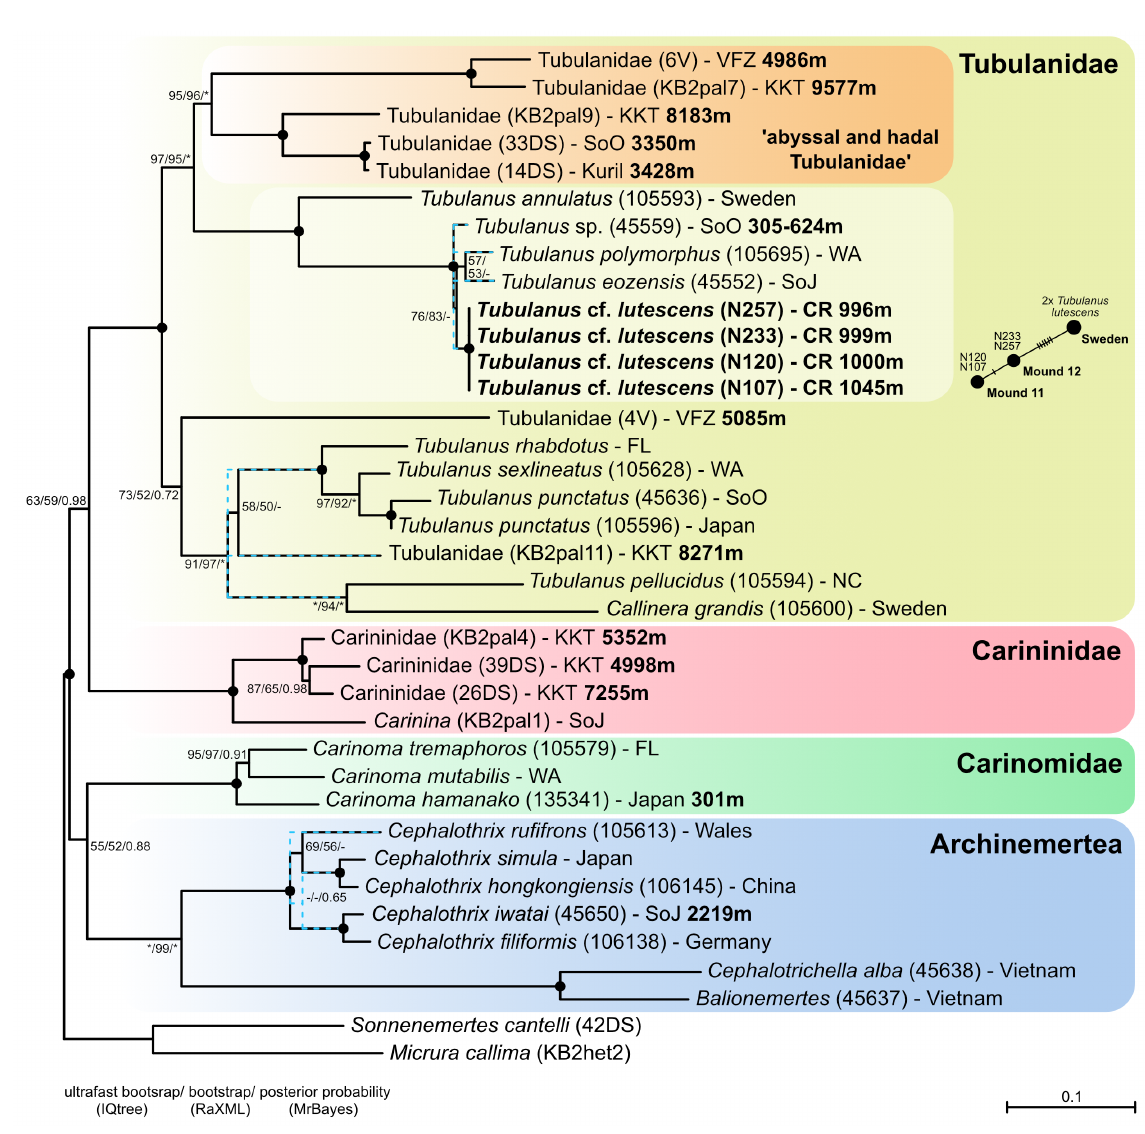
Fig. 2. Maximum likelihood (ML) tree for the palaeonemertean supermatrix based on the concatenated four gene dataset (16S, COI, 18S, H3). Numbers beside nodes indicate support values. Black circles indicate nodal support of 100/100/1.0; asterisks indicate nodal support of either 100/ or /1.0. Alternative branches found in the BI analysis are given as blue dotted lines. Sonnenemertes cantelli Chernyshev, Abukawa & Kajihara, 2015 and Micrura callima Sundberg & Gibson, 1995 were used for outgroup rooting. Specimens belonging to the new species Tubulanus cf. lutescens are highlighted in bold. When available a specimen-ID, sampling locality, and depth (for deep-sea species) are provided. A statistical parsimony haplotype network based on the COI gene fragment reveals close relationship between Tubulanus cf. lutescens and Tubulanus lutescens